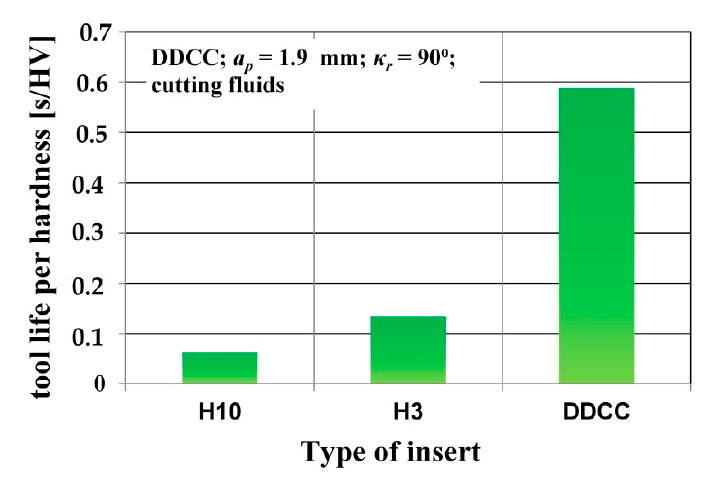
Figure 12. Tool life per hardness for tested cutting inserts within the range of v c = 800 m / min, f = 0.15 mm / rev.